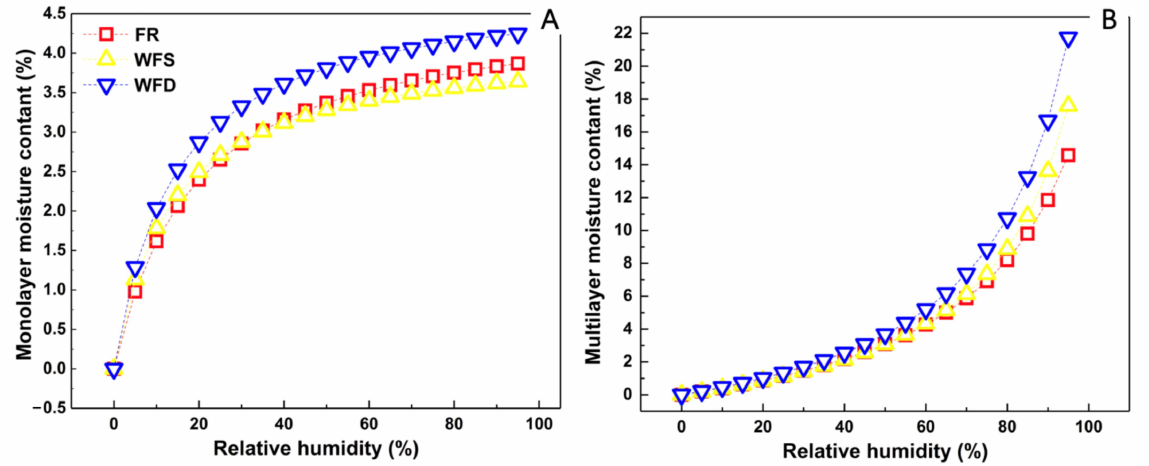
Figure 4. Water content obtained from the H–H model. ( A ) Histogram of monolayer moisture content. ( B ) Diagram of multilayer moisture content. FR: recent fir wood, WFS: waterlogged archaeological fir wood from a sound region, WFD: waterlogged archaeological fir wood from a decay